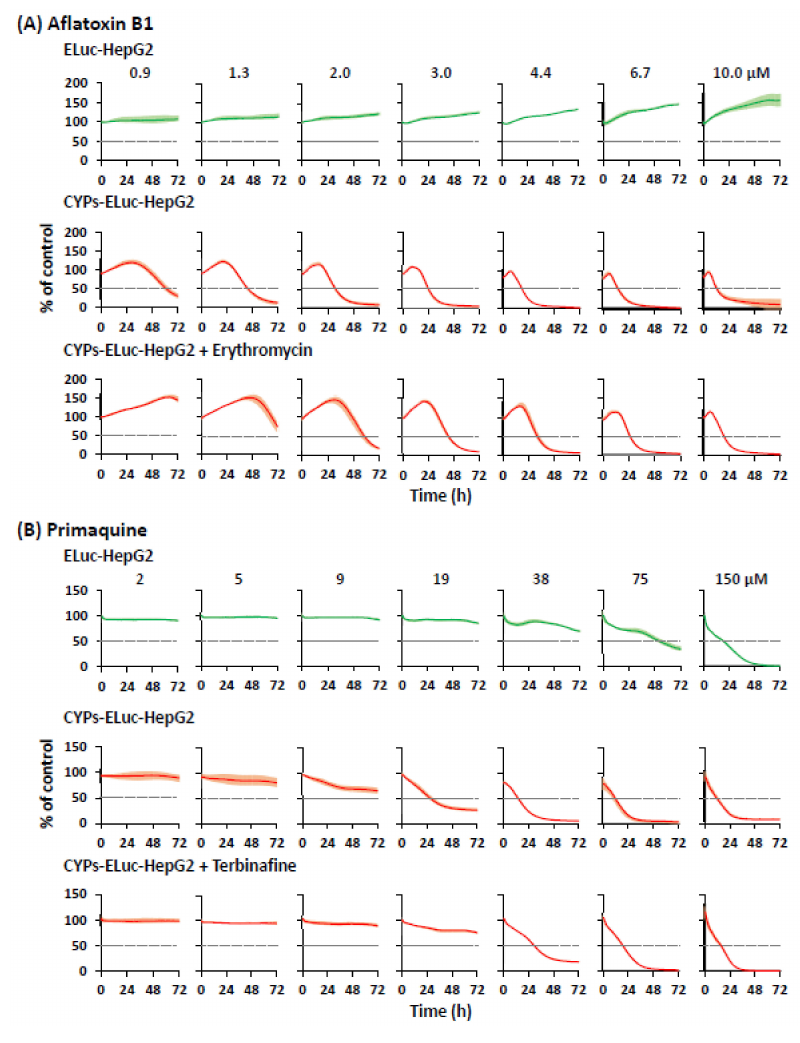
Figure 5. Real-time bioluminescence measurement of aflatoxin B1- or primaquine-treated ELuc- HepG2 and CYPs-ELuc-HepG2 cells. ELuc-HepG2 cells (upper panels) and CYPs-ELuc-HepG2 (middle panels) were treated with aflatoxin B1 ( A ) or primaquine ( B ), or co-treated with aflatoxin B1 plus CYP3A4 specific inhibitor erythromycin (12 µ M) ( A , bottom panels) or primaquine plus CYP2D6 specific inhibitor terbinafine (1 µ M) ( B , bottom panels). Bioluminescence was measured in real time for 5 s at 15-min intervals for 3 days. Data are expressed as percentage of vehicle control cells (set at 100%) at each time point and shown as means ± standard deviations ( n =